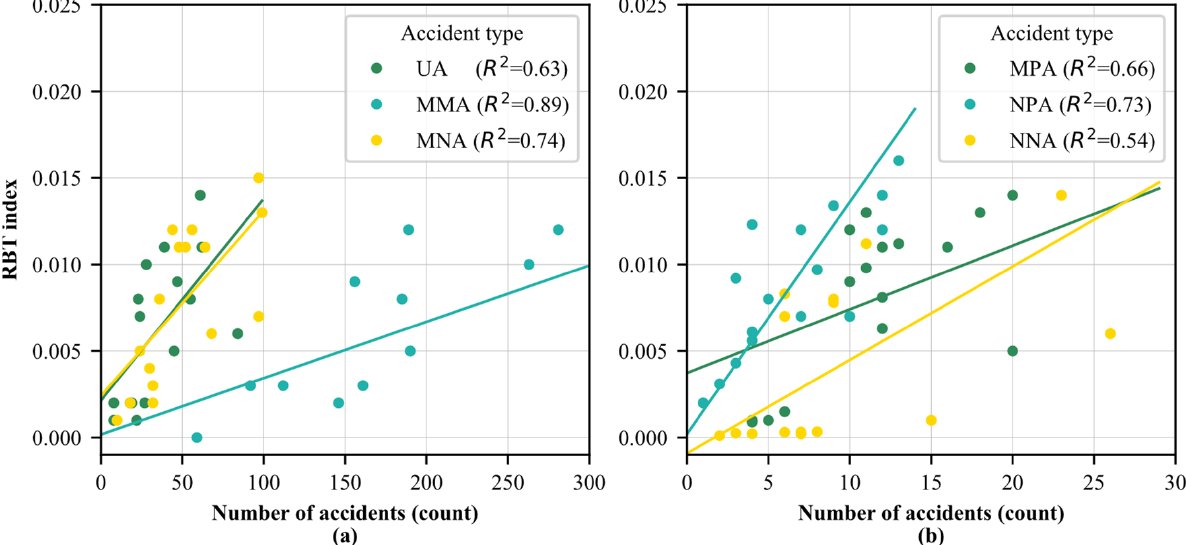
Figure 6. Correlation between the RBT index and the number of accidents: ( a ) correlation analysis of UA, MMA and MNA, ( b ) correlation analysis of MPA, NPA and NNA.